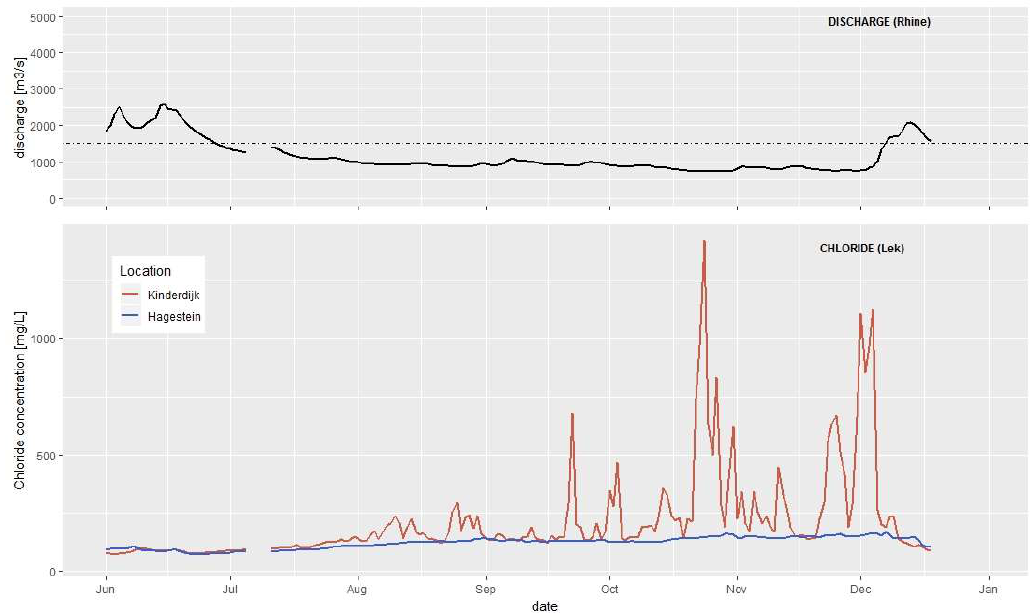
Figure 3. Flow of the Rhine River and salinization of the mouth of the Lek during a hydrological drought in the second half of 2018. Averaged on daily basis but based on 10 min